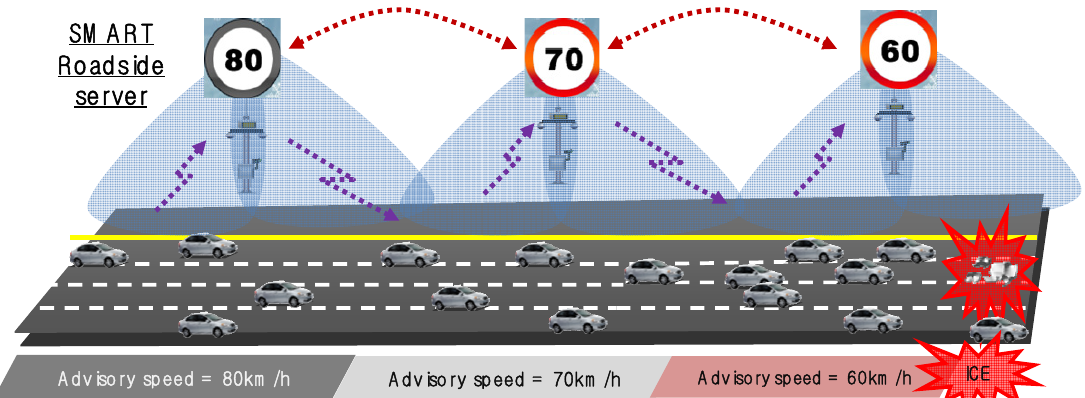
Figure 8. Advisory speed provisioning in a highway